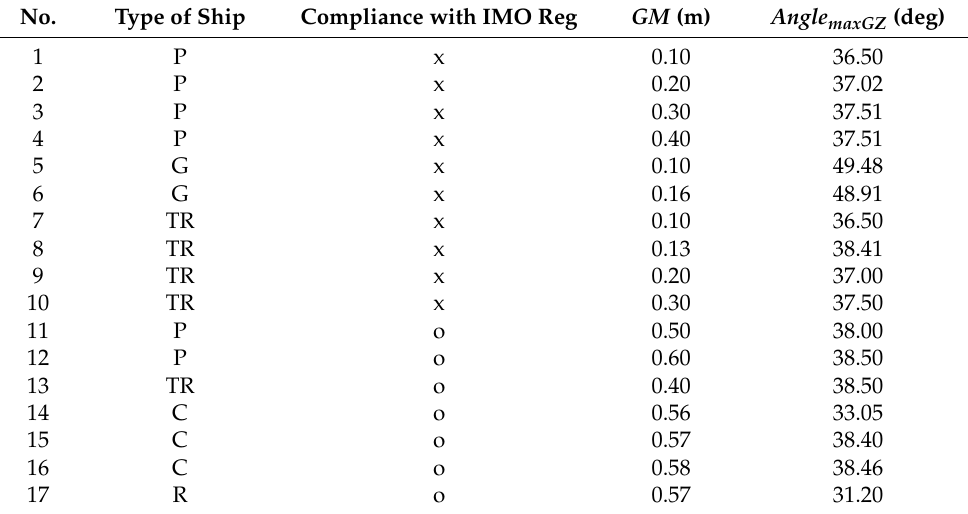
Table 5. Angle maxGZ in the low GM .